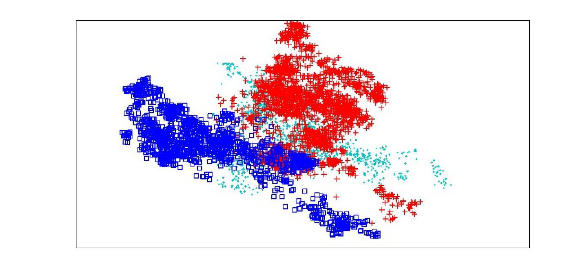
Figure 7. PCA (Principal Component Analysis)